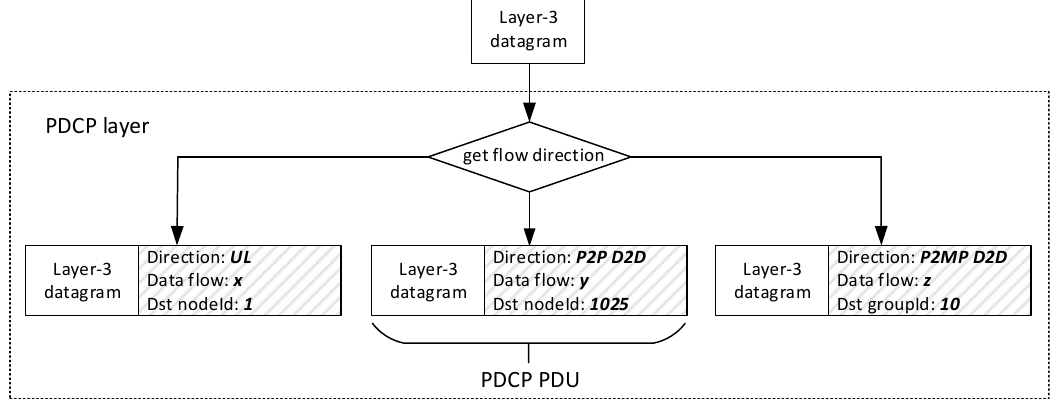
Figure 10. Processing of upper-layer packets at the PDCP layer.